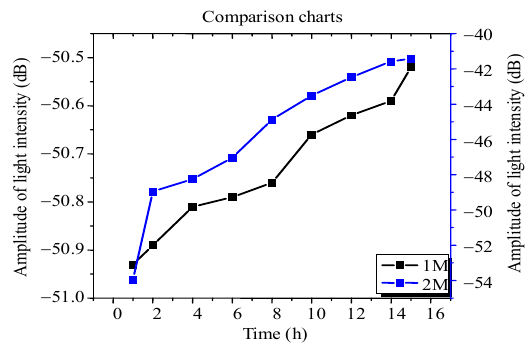
Fig. 6 Amplitude of the light